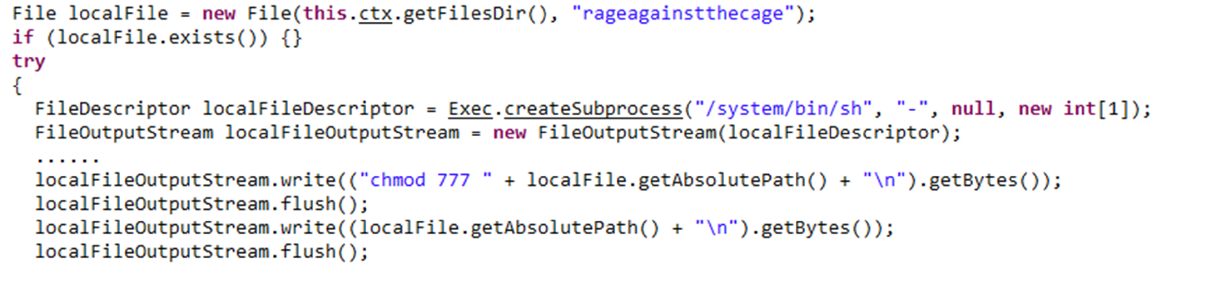
Figure 7. Implementation code for root privilege escalation in the sample of DroidDream. There are three key steps in the code.